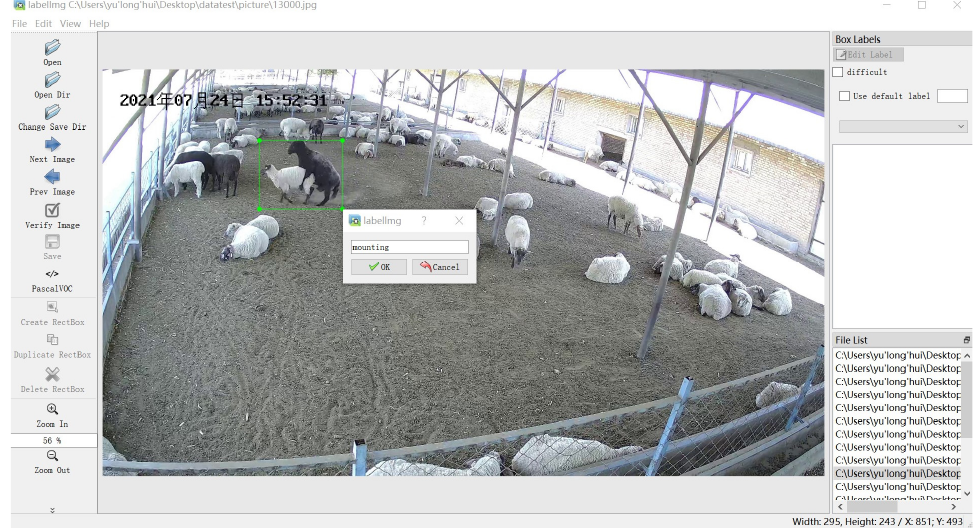
Figure 4. Dataset label making. The Chinese characters in the upper left corner of the image are the date of the video recording, in order of year, month, and day.